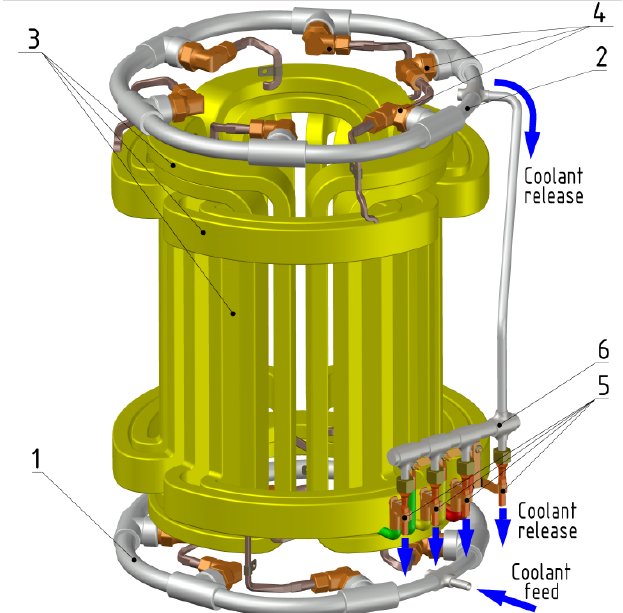
Figure 1. Components of the EMM cooling system: 1. inlet collector; 2. outlet collector; 3. coil channels; 4. fittings; 5. connects; 6. additional collector.